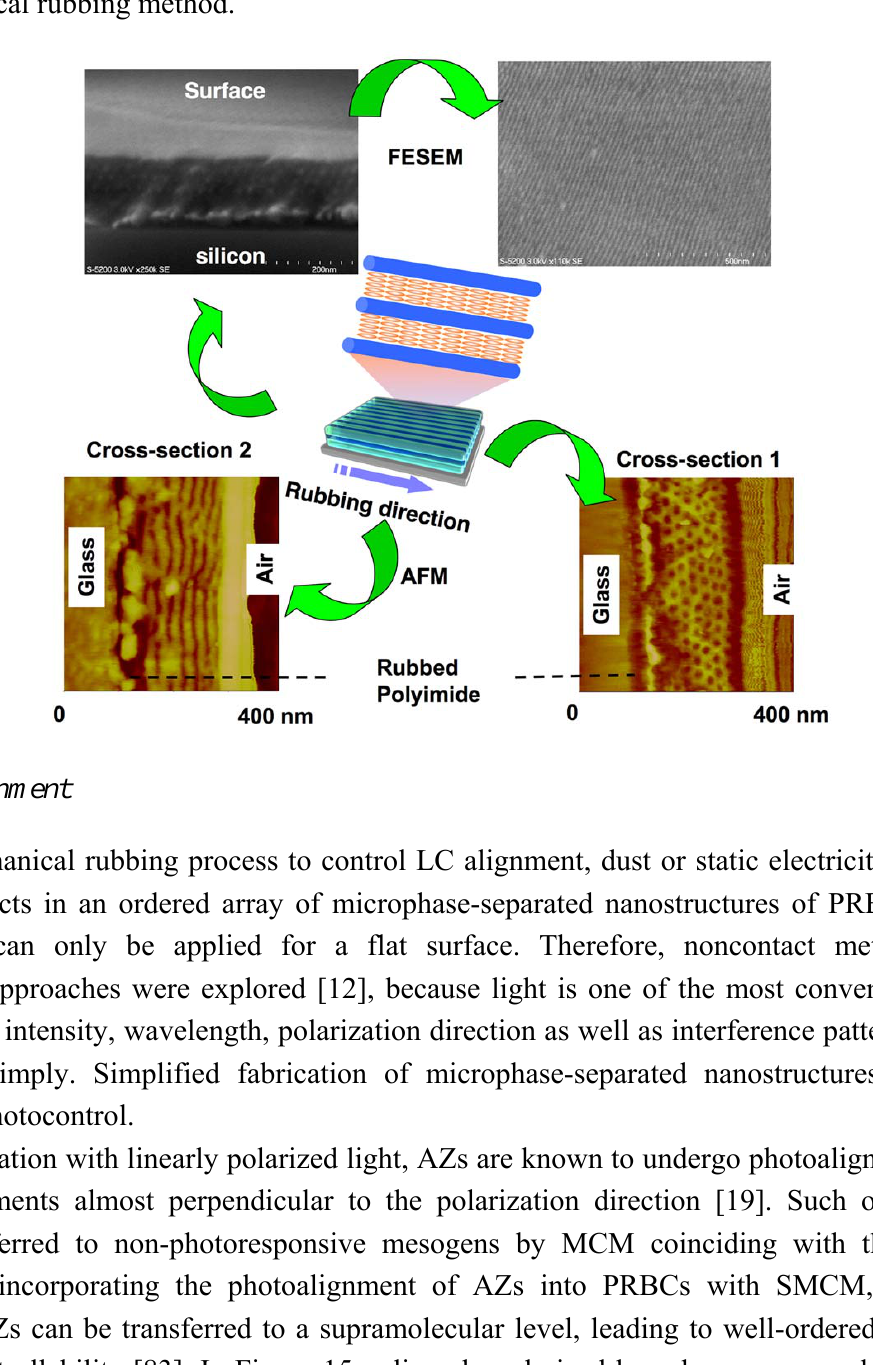
Figure 14. Fabrication of a parallel nanocylinder array in a PEO-based PRBC by the mechanical rubbing